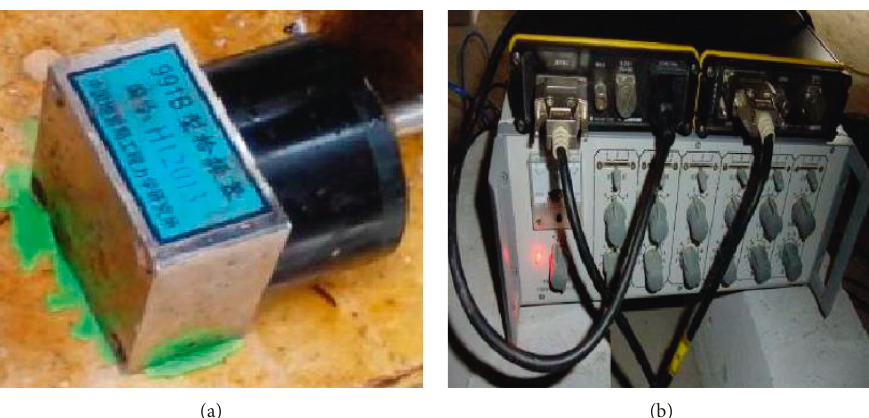
Figure 8: Measuring point and the amplifier of vibration pickup. (a) Measuring point 7. (b) Amplifier of vibration pickup.